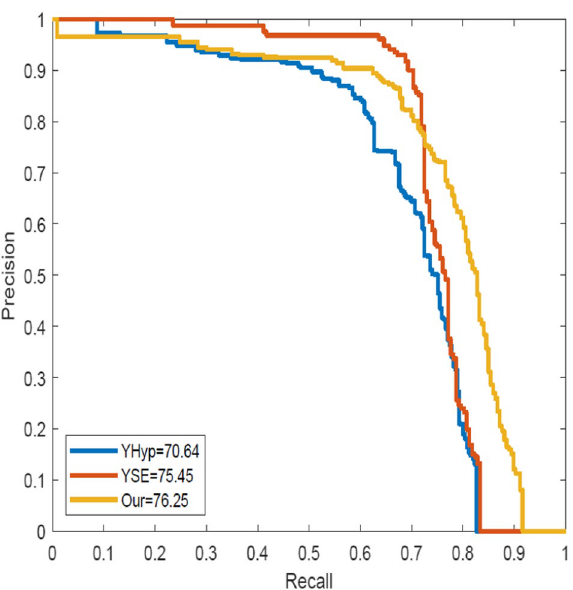
Fig. 18 The value of AP in the Skating and Skiing shoes